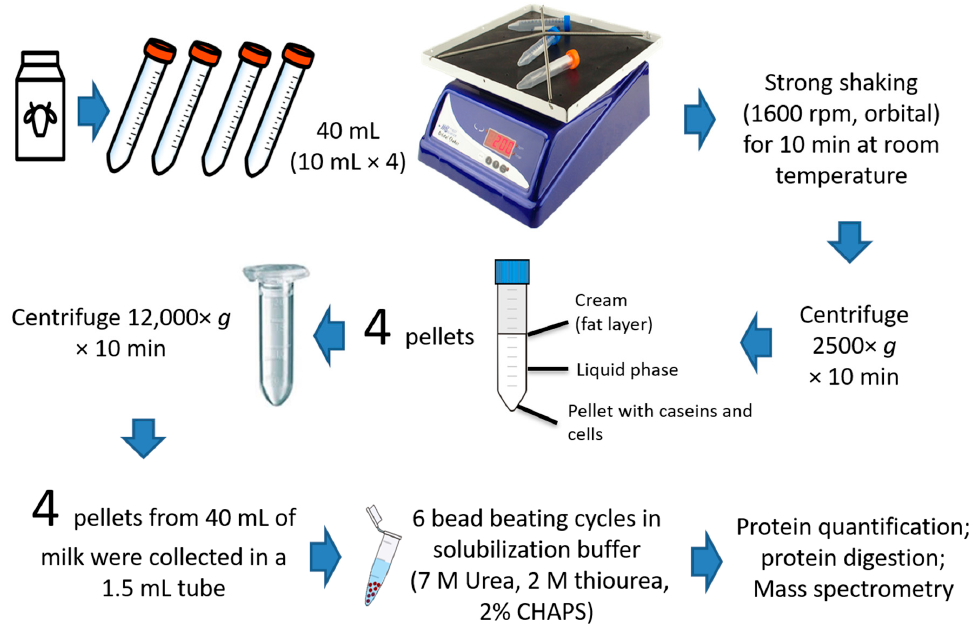
Figure 1. Workflow of the rapid bacterial enrichment method. The experimental phases of the whole procedure prior to the mass spectrometry analysis are described, starting with the separation of the bacterial fraction from the lipid fraction, to the collection and enrichment of the bacterial